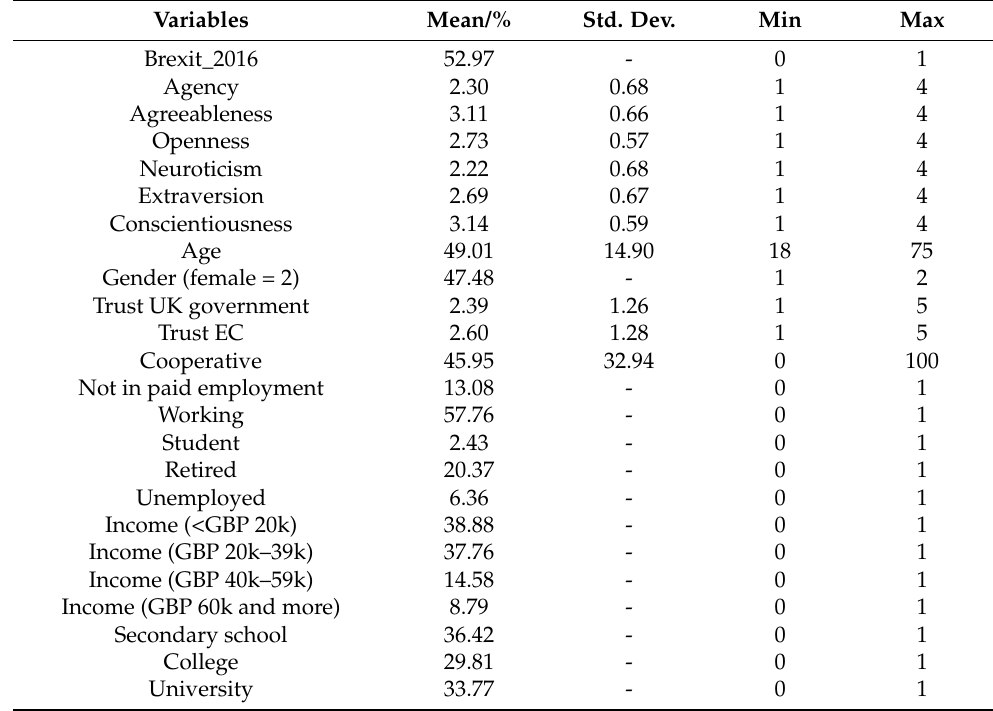
Table 2. Descriptive statistics of dependent variable and covariates used in the Probit model.